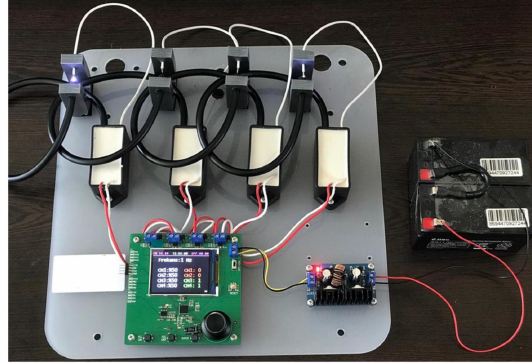
Figure 8. Working test of the experimental